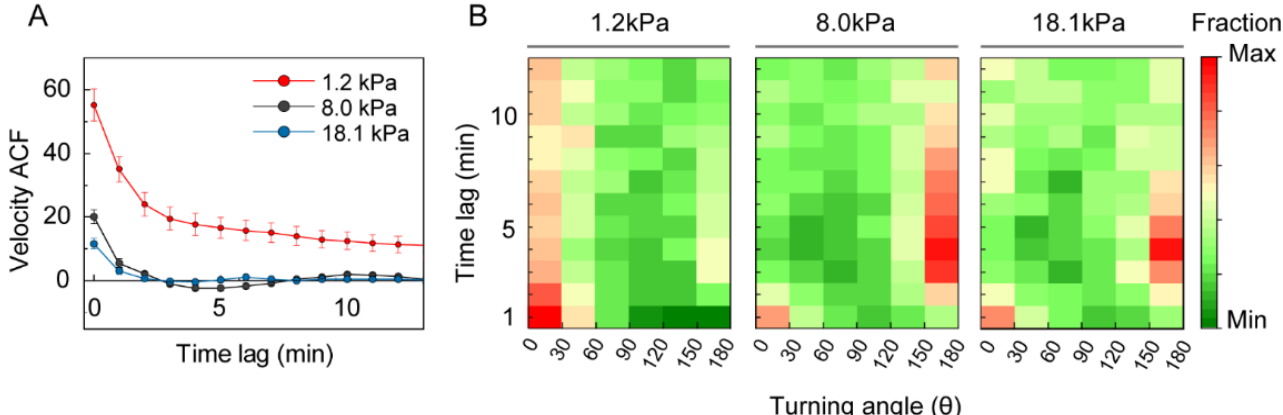
Figure 4. ACF and turning angle distribution of DCs migrating under different mechanical loads. ( A ) Velocity ACFs plotted to depict the velocity correlation at different time scales. Lines indicate mean ACFs from three independent experiments and error bars represent S.E. ( B ) Turning-angle distribution depending on time lag. Squares depict the fraction of the turning angle (bin size = 30°), indicated by relative color coding. Data were pooled from three independent biological replicates; 1.2 kPa, n = 195; 8.0 kPa, n = 123; 18.1 kPa, n = 81.